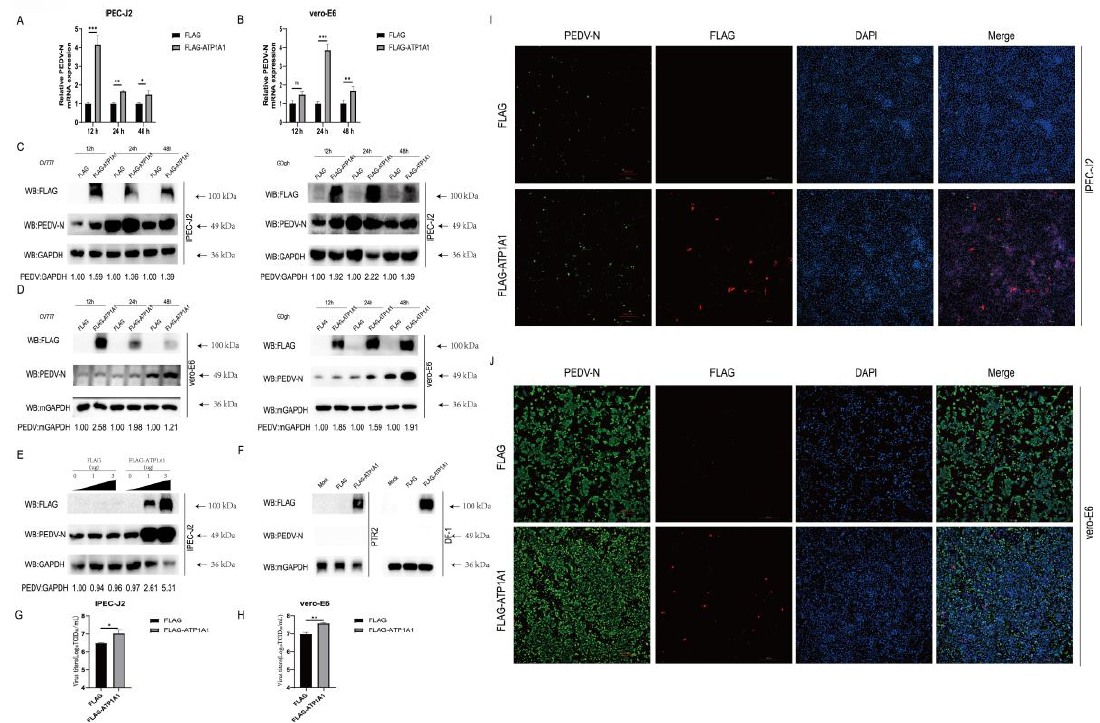
Figure 5. Overexpression of ATP1A1 promotes PEDV infection. ( A , B ) Overexpression of ATP1A1 significantly upregulates PEDV RNA abundance. Transfected with FLAG or FLAG-ATP1A1 vector for 24 h, cells were collected at 12, 24 and 48 h after PEDV at 0.1 MOI infection of target cells for quantitative PCR assay. Data represent means ± SD from three independent experiments. *, p < 0.05; **, p < 0.01; ***, p < 0.001; ns, no significant difference. ( C , D ) Overexpression of ATP1A1 remarkably facilitates the PEDV N protein expression. After overexpressing of ATP1A1 for 24 h, target cells were infected with PEDV (CV777-G1 or GDgh-G2) at 0.1 MOI and collected and lysed at different time points for Western blot analysis. ( E ) ATP1A1 promotes the expression of PEDV N protein in a dose-dependent manner. Cells were transfected with increasing concentrations of a vector expressing FLAG-ATP1A1. At 24 h post-transfections, the cells were infected with PEDV at 0.1 MOI, and the cell lysates were collected for analysis of PEDV N protein expression with Western blotting. ( F ) PTR2 and DF-1 cells overexpressing of ATP1A1 gene maintained resistance to PEDV infection. Cells overexpressed with ATP1A1 were infected with PEDV at 0.1 MOI for 24 h, and the cell lysates were collected for analysis of PEDV N protein expression with Western blotting. ( G , H ) Overexpression of ATP1A1 enhances PEDV viral titers. Cells overexpressed with ATP1A1 were infected with PEDV at 0.1 MOI infected for 24 h, and cell supernatants were extracted for TCID 50 assay. Data represent means ± SD from three independent experiments. *, p < 0.05; **, p < 0.01. ( I , J ) Overexpression of ATP1A1 enhances PEDV infection. Cells were transfected with FLAG or FLAG-ATP1A1 vector for 24 h, and then PEDV (0.1 MOI) infected for 24 h. The cells were stained with anti-ATP1A1 mAb (red) and anti-PEDV-N mAb (green). Staining of cell nuclei using DAPI (blue) staining solution. The processed samples were photographed and analyzed using fluorescence microscopy. Scale bars, 200 µ